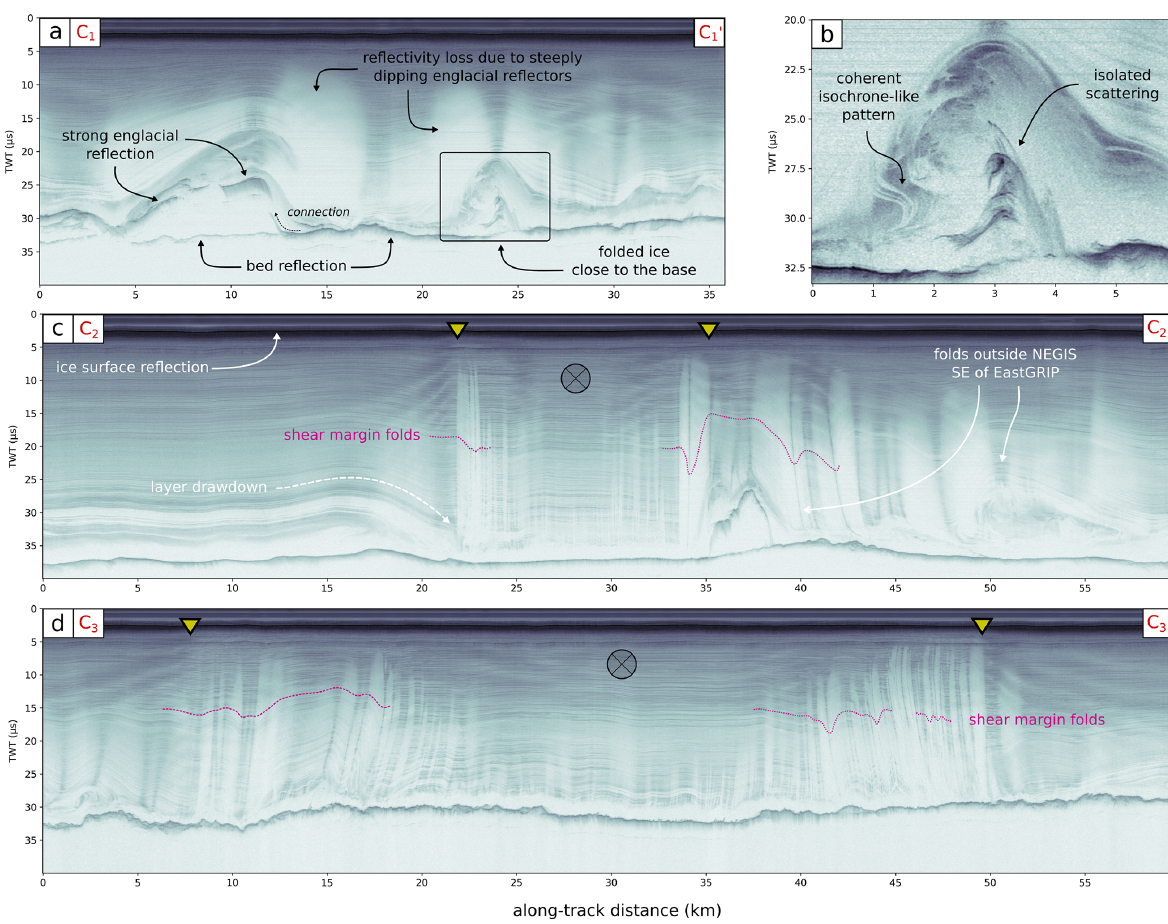
, C 2 − C (cid:48) , and C 3 − C (cid:48) (frames 20180508_06_003, 20180511_01_007, and 20180514_01_011–012, respec- Figure 3. Radar profiles C 1 − C (cid:48) 1 2 3 tively). The corresponding locations are shown in Fig. 1a. Panel (a) shows a profile located outside of the NEGIS, southeast of EastGRIP. A close-up of an anticline and other patterns of deformation are shown in panel (b) , resembling the skeleton of a dead penguin. A slice through the ice stream in the upstream region is shown in panel (c) and a radar section further downstream in (d) . The position of the shear margins (the maximum in the surface velocity gradient) is indicated with a yellow triangle and the folds in the shear margin areas with purple lines. The ice flow direction is into the